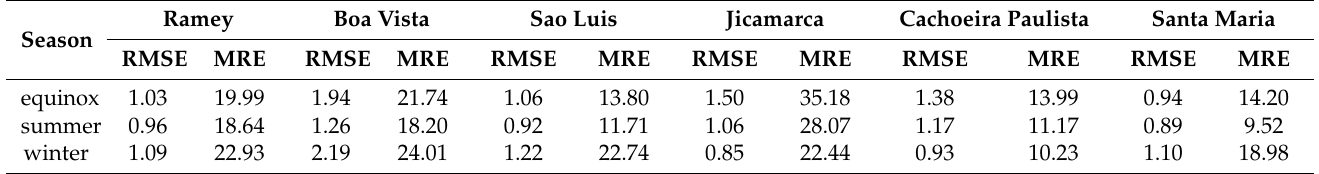
Table A3. Statistics of the differences in N m F 2 obtained from the COSMIC-2 and ionosonde (as the reference) at the six ionosondes under quiet geomagnetic conditions in terms of RMSE (10 5 el/cm 3 ) and mean |RelE| (MRE, %) in different seasons.